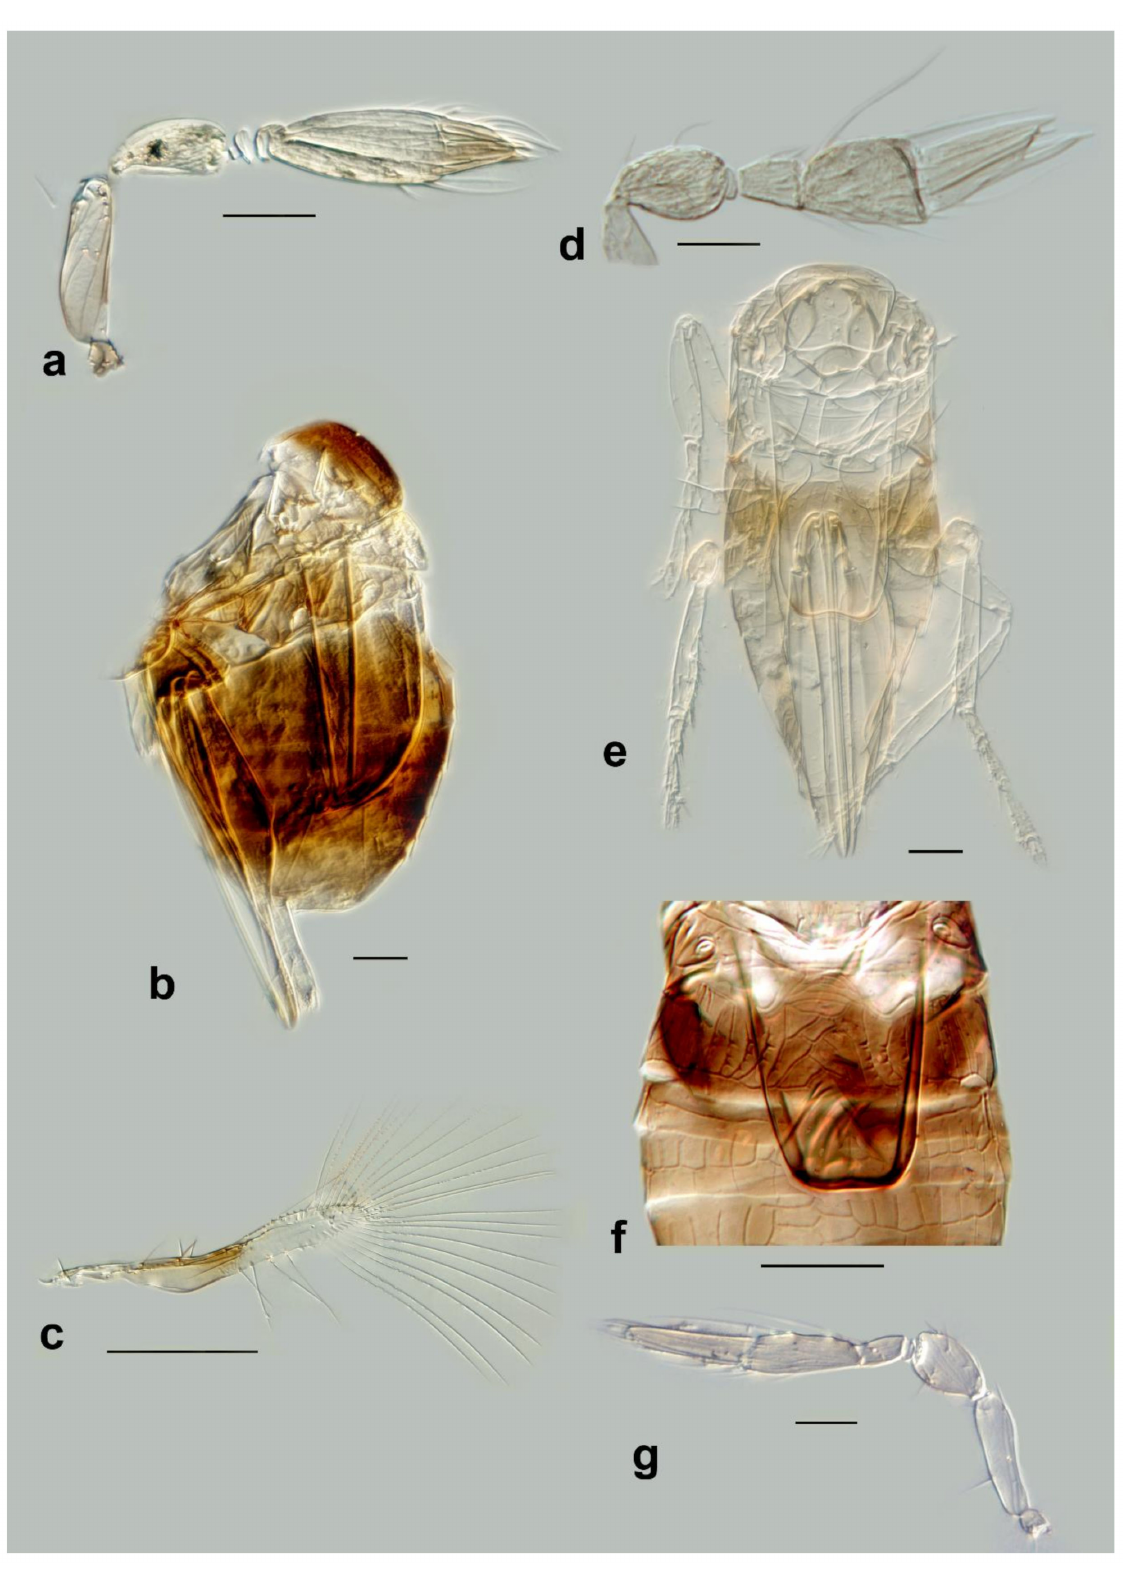
Figure 17. Photographs of Megaphragma species: ( a ) M. momookherjeeae , female antenna (Holotype); ( b ) M. momookherjeeae , female lateral meso-and metasoma (Holotype); ( c ) M. momookherjeeae , female fore wing (Holotype); ( d ) M. mymaripenne , female antenna (Holotype); ( e ) M. nowickii , female dorsal meso- and metasoma (Holotype); ( f ) M. nowickii , female dorsal base of metasoma (Holotype); ( g ) M. nowickii , female antenna (Holotype). Scale bars 20 µ m except 100 µ m for